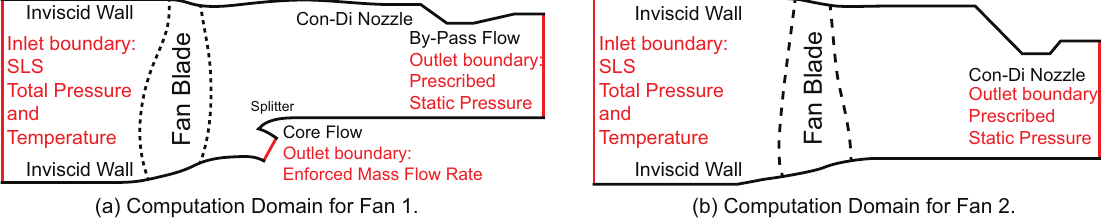
Figure 3. Computation domains for the two fans. Meridional view. Not to